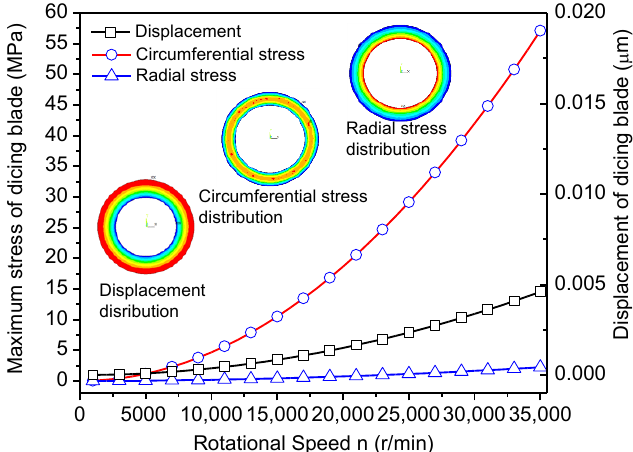
Figure 7. Maximum stress and displacement of the dicing blade with different rotational speed.